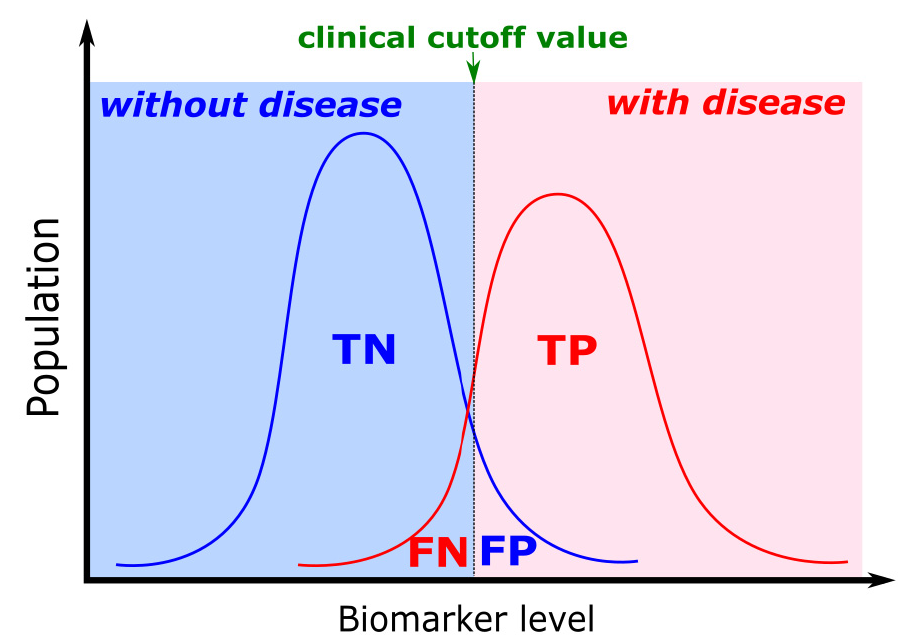
Figure 11. The clinical cutoff level of the biomarker to determine the physiological state of the patient. (TN: true negative; TP: true positive; FN: false negative; FP: false positive).